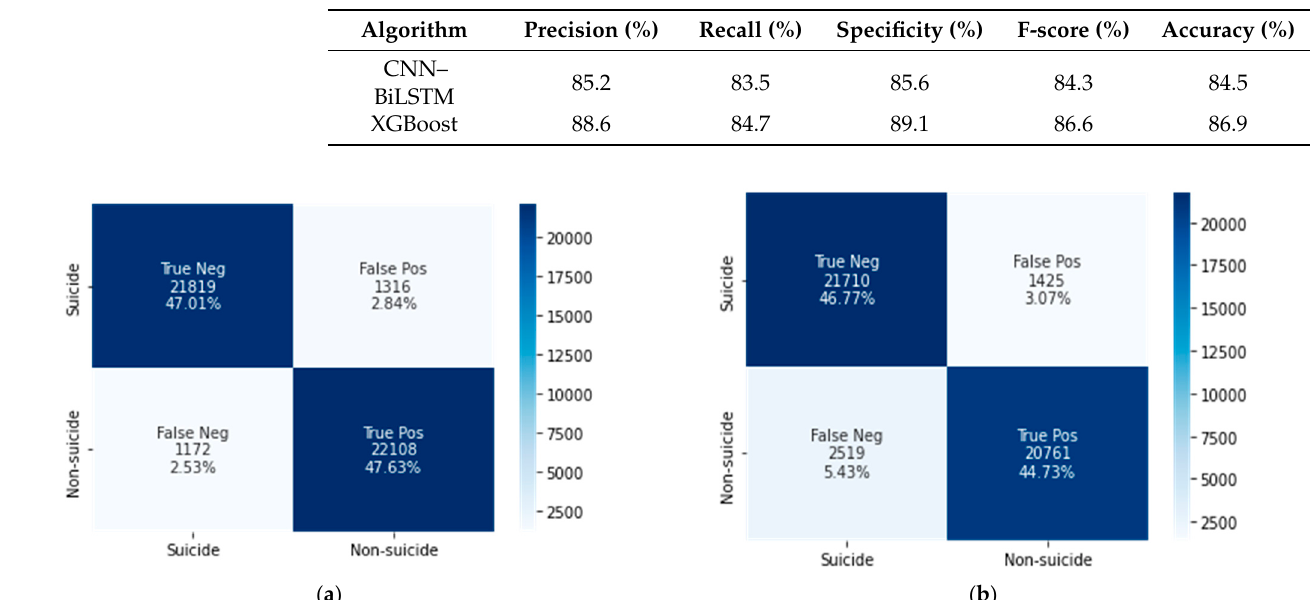
Figure 3. Confusion matrices of ( a ) CNN–BiLSTM and ( b ) XGBoost using textual features.